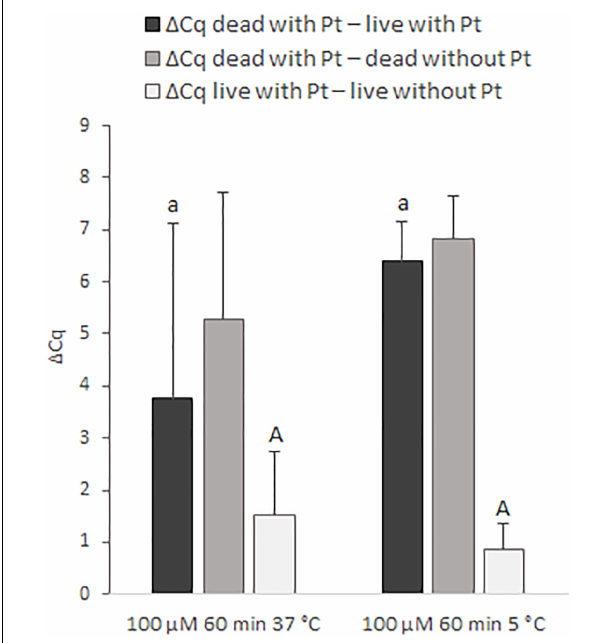
FIGURE 4 | Effect of different incubation temperatures (37 and 5 ◦ C) on the treatment of M. smegmatis cells with 100 µ M cis-dichlorodiammine platinum(II) for 60 min. The aim was to find the incubation temperature providing the highest possible value for (cid:49) Cq dead with Pt − live with Pt and (cid:49) Cq dead with Pt − dead without Pt and the lowest possible value for (cid:49) Cq live with Pt − live without Pt . The (cid:49) Cq values express the individual mean differences of Cq values calculated from four replicates (biological and technical). The significance of differences between (cid:49) Cq was calculated by Welch’s t -test. The same letters indicate statistically insignificant differences ( P > 0.05) between (cid:49) Cq values, while different letters indicate significant differences ( P < 0.05). The values of (cid:49) Cq dead with Pt − live with Pt were marked with lowercase letters, and the values of (cid:49) Cq live with Pt − live without Pt were marked with capital letters, as it was evaluated separately. Error bars represent standard deviations calculated from four